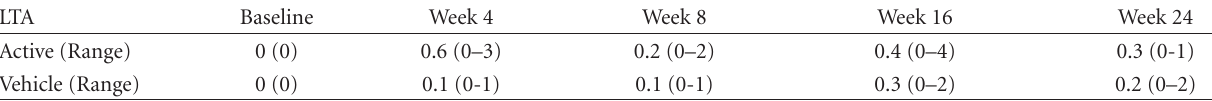
Table 9: Mean Local Tolerability Assessments (LTA) (Investigator).